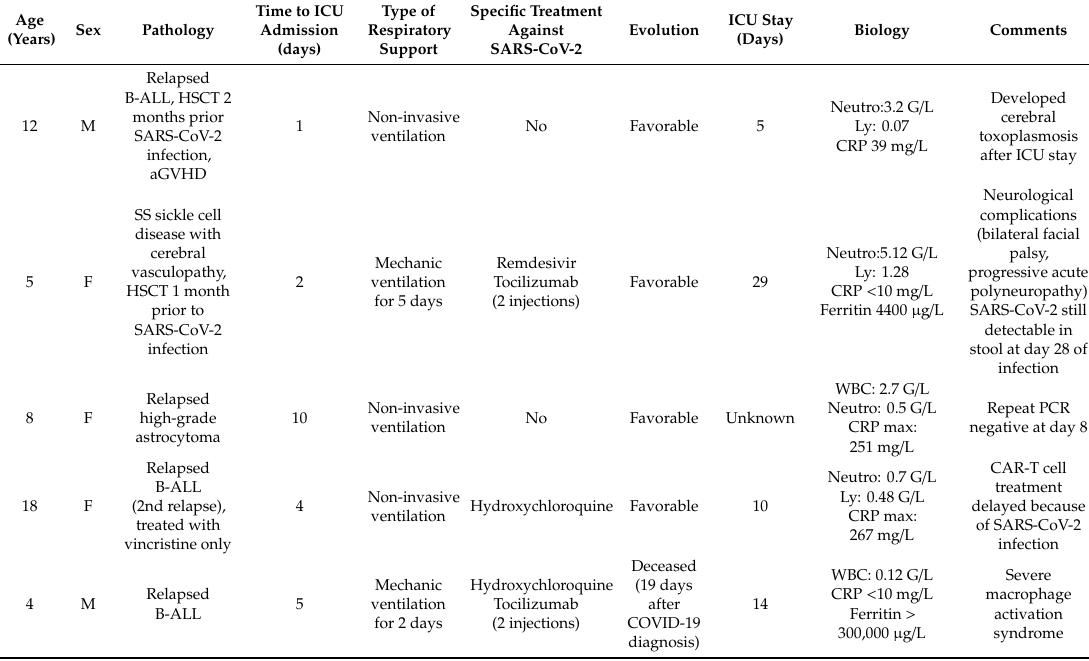
Table 3. Clinical characteristics of patients admitted in an intensive care unit for